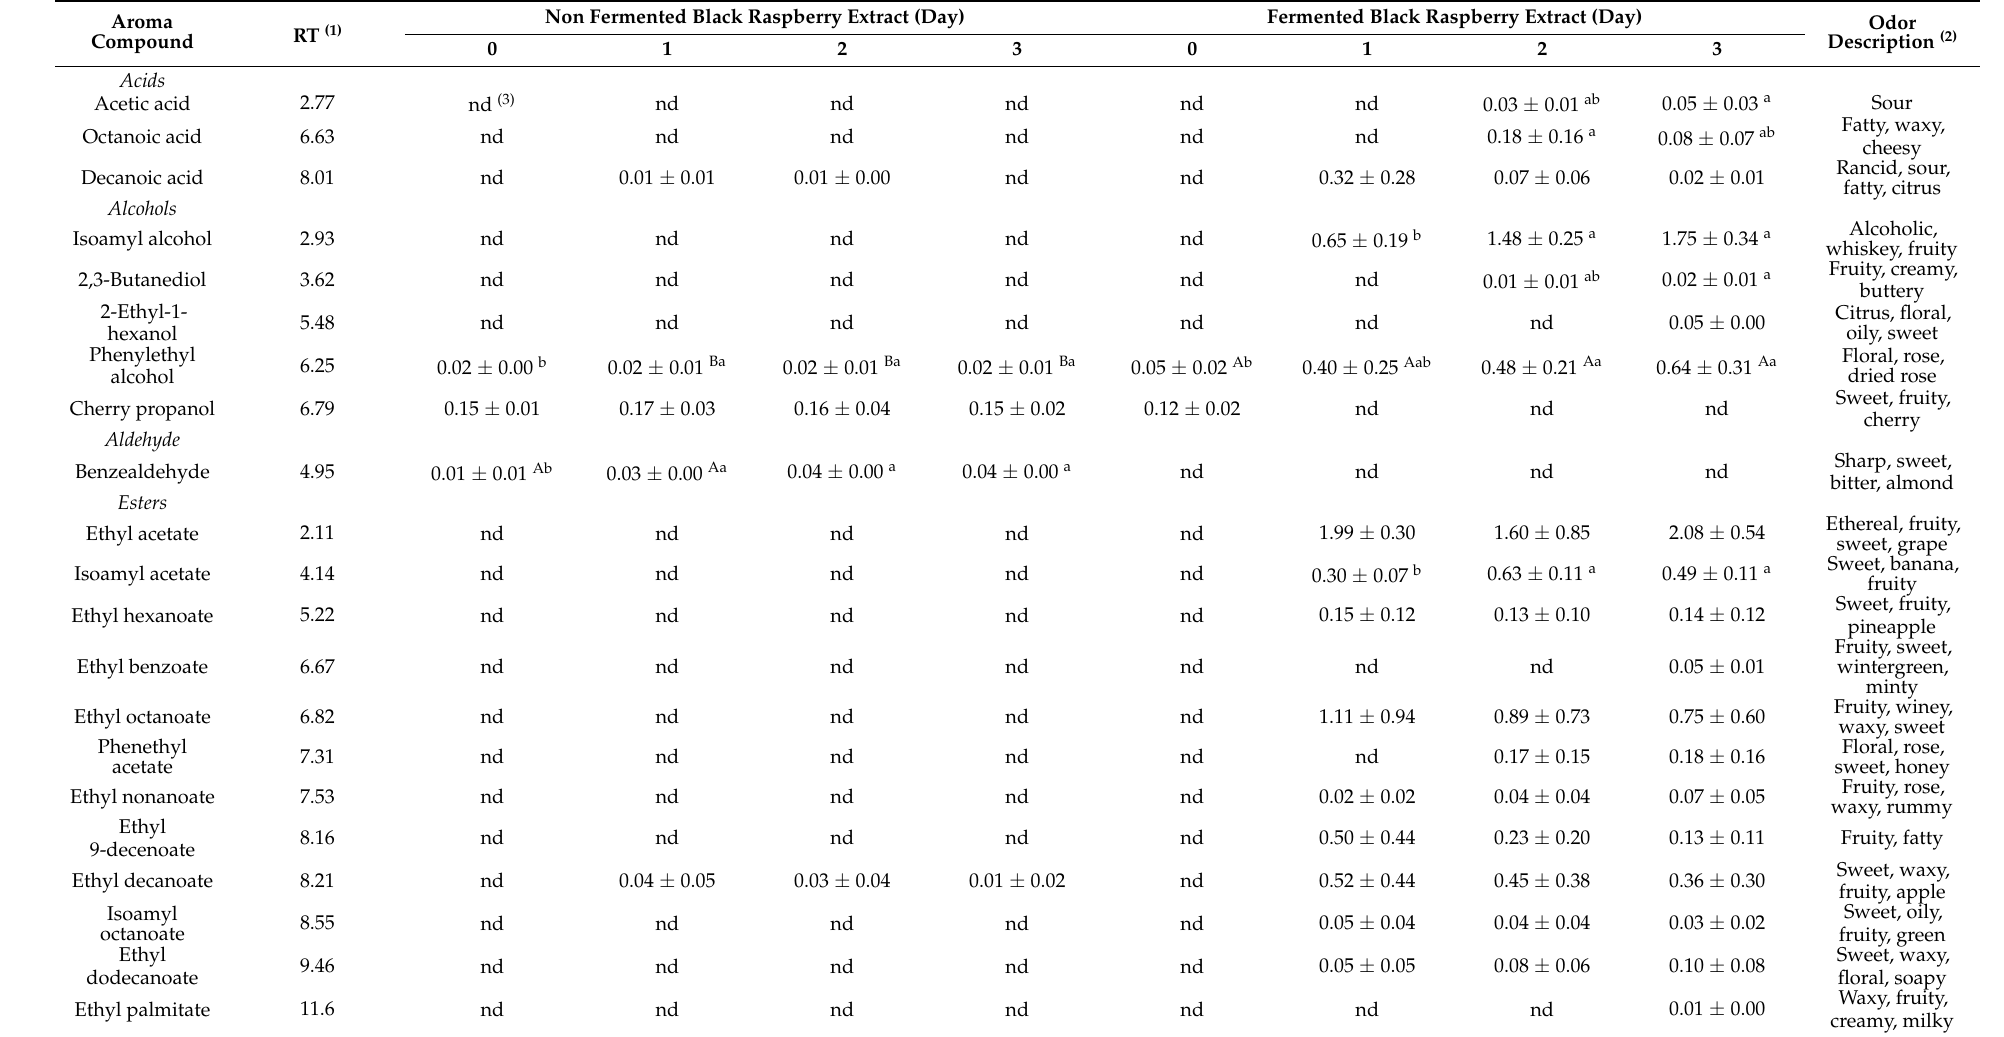
Table 4. Change of volatile flavor compound contents during black raspberry fermentation by Pediococcus acidilactici